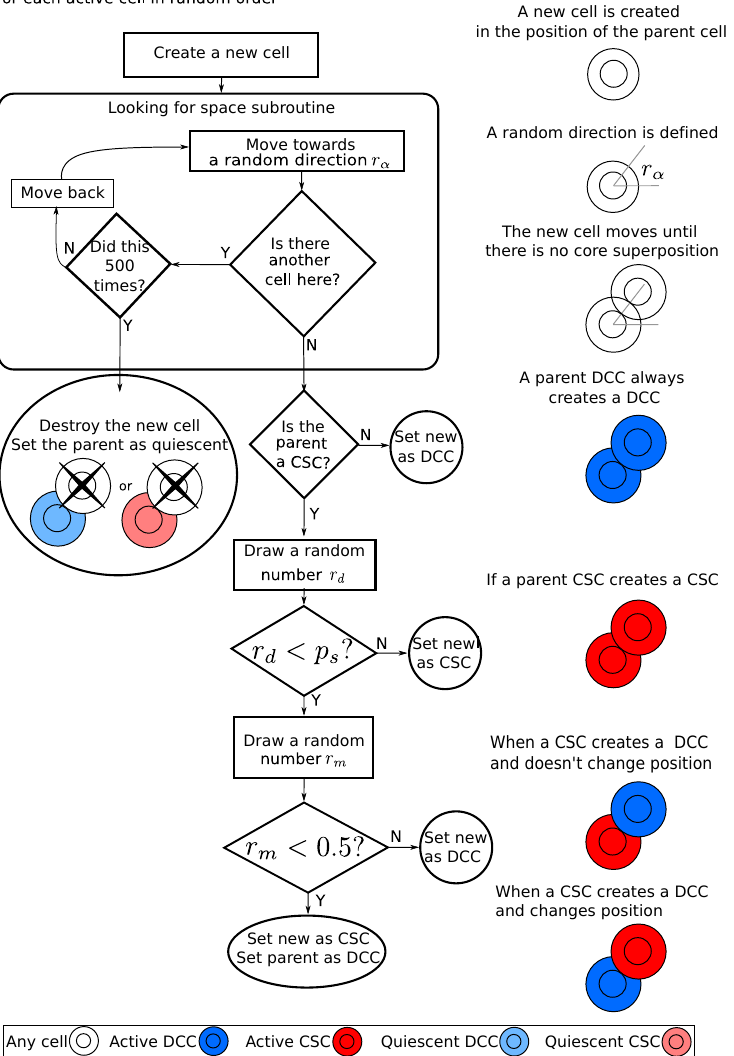
Figure 7: Left: Flow chart for the proliferation process of each cell. Right: Illustration of the stages and outcomes of the duplication